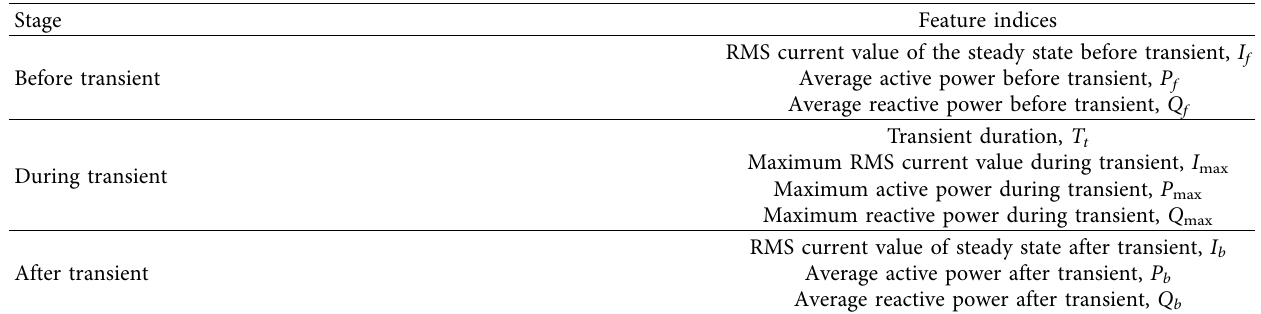
Table 2: Load transient feature indices of industrial